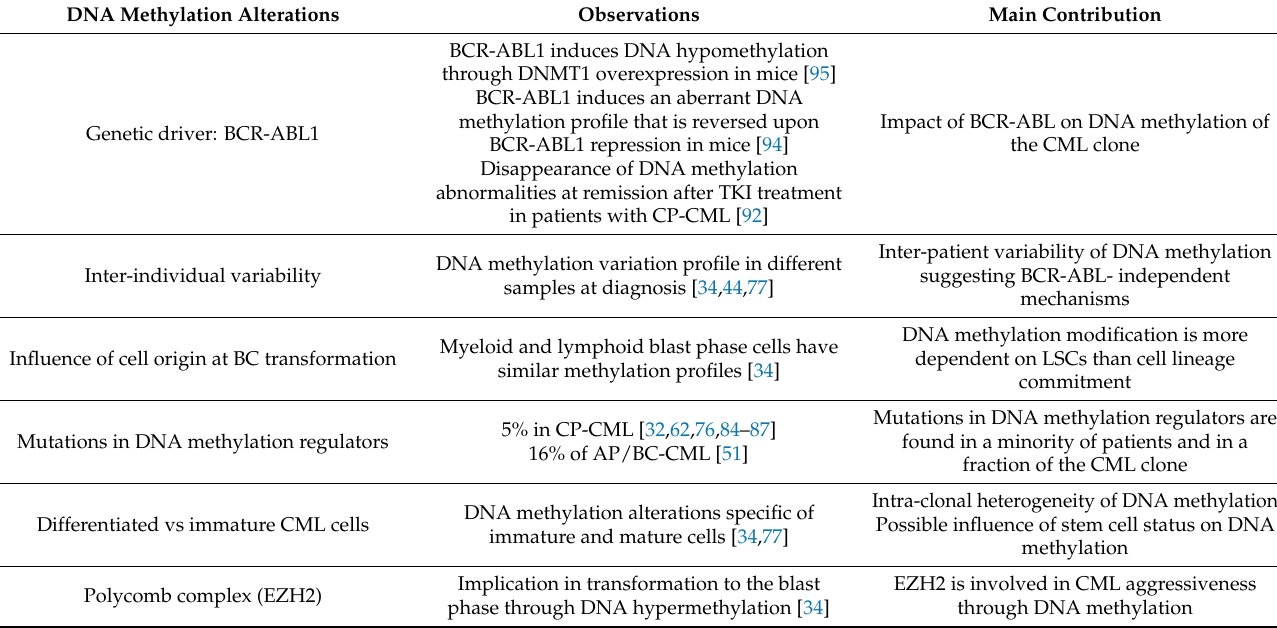
Table 2. DNA methylation alterations and intra-clonal